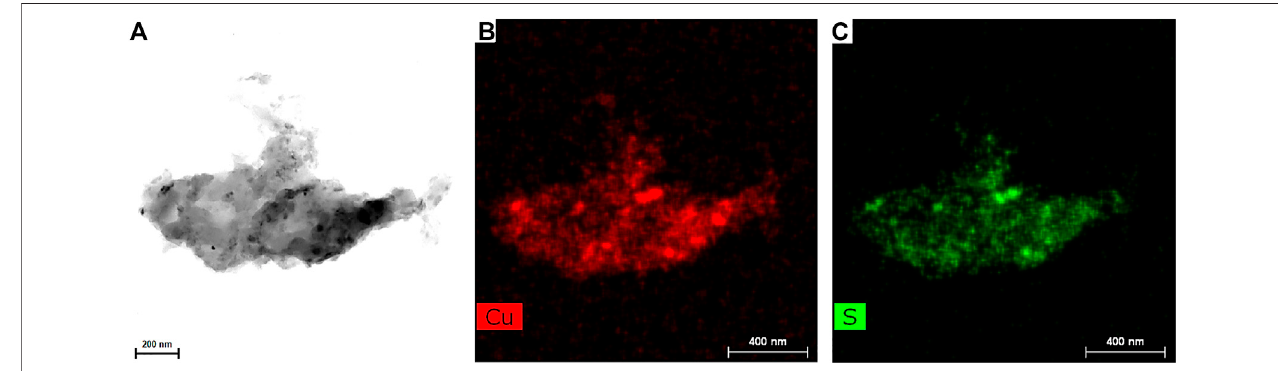
FIGURE 10 | (A) The high-angle annular bright- fi eld TEM image, (B , C) EDS images for elemental mapping Cu and S elements of the washed CuS-BSA